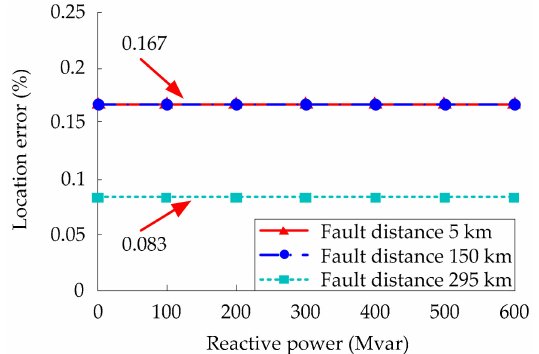
Figure 11. Location error with different output reactive power.